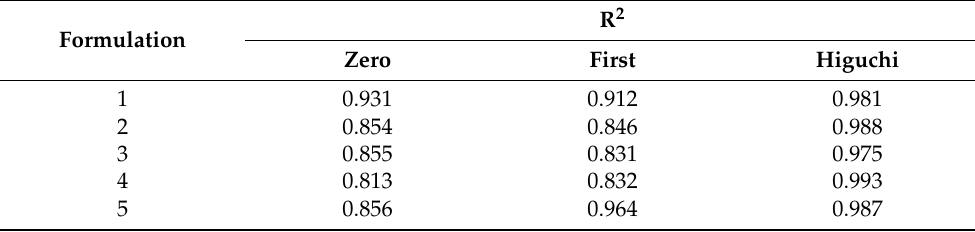
Table 3. Mathematical modeling of release